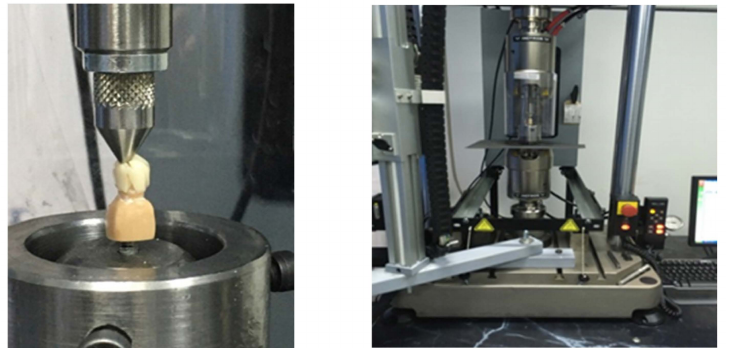
Figure 1. Load-to-fracture test in the universal testing machine before the placement of the tin foil, stating loading test in the universal testing (Instron 3366, Instron Corp, Norwood, MA,